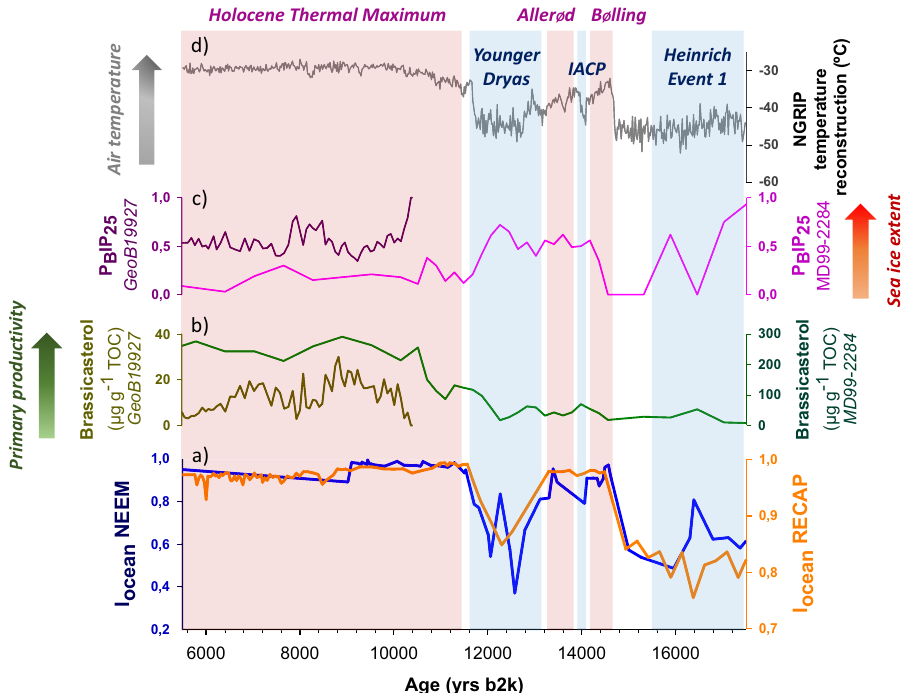
Fig. 4 I ocean variability in Greenland ice cores during the Last Glacial Termination/Holocene transition. From bottom to top: a I ocean values in NEEM (dark yellow) and RECAP (red) ice cores; b , c Arctic primary productivity and sea ice evolution ( brassicasterol and P B PIP 25 pro fi les, respectively) in Baf fi n Bay (core GeoB19927) 60 and the Norwegian Sea (core MD99-2284) 46 ; d Greenland air temperature reconstruction from NGRIP 64 . Bands indicate the main cold (blue) and warm (red) climatic phases of this period (IACP = Intra-Allerød Cold